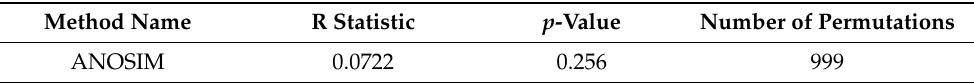
Table 4. Species composition ANOSIM difference analysis results between groups.